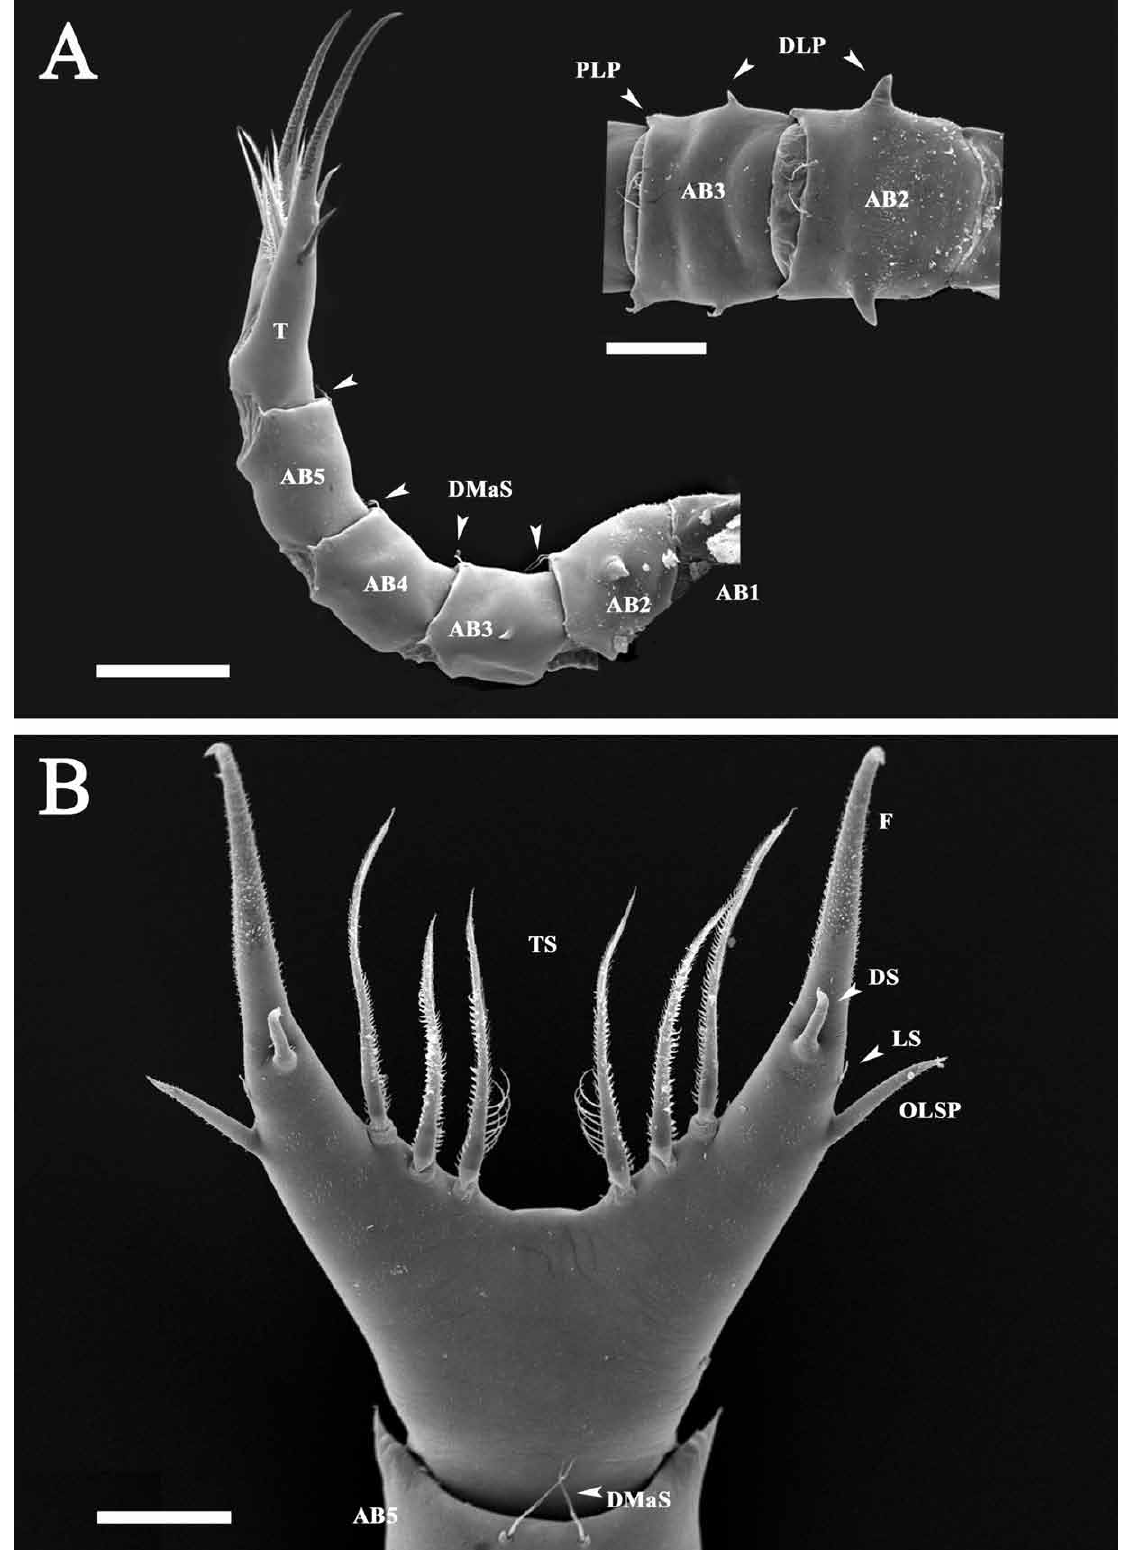
dorsal spine, F : furca, LS : lateral spine, OLSP : outer lateral spine, PLP : posterior-lateral process, T : telson, TS : telson